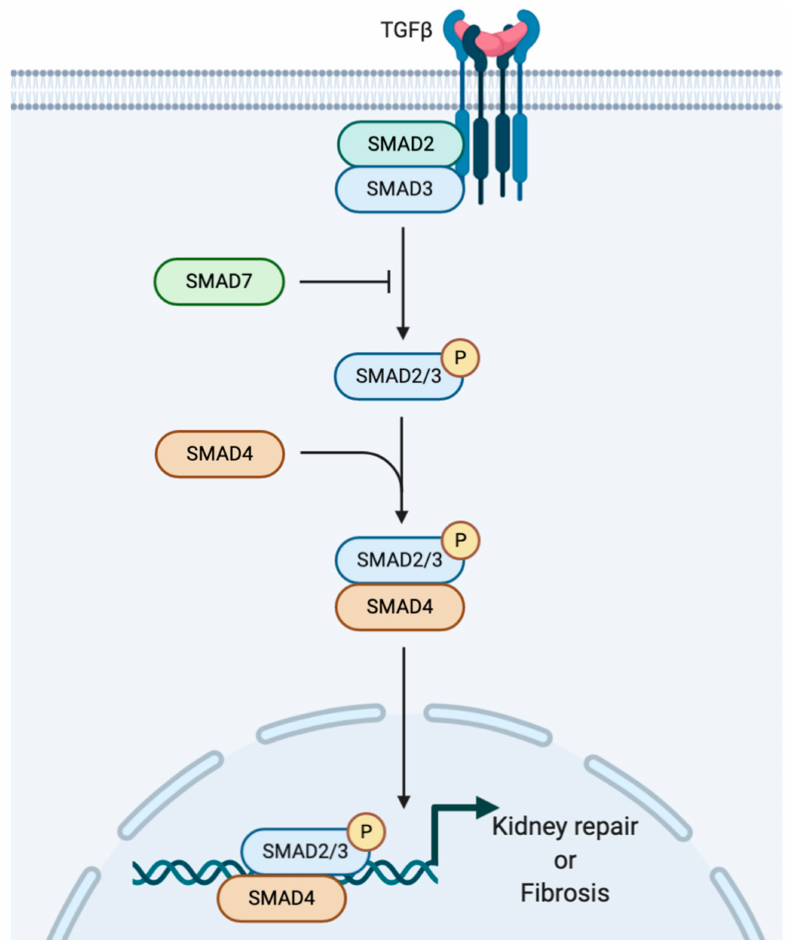
Figure 4. The role of TGF β in renal fibrosis. TGF β engages the ALK receptors to activate SMAD2-4 transcriptional programme. Initially TGF β plays a protective role by enhancing ECM production, such as COL1A2 , leading to tissue repair. However, excessive TGF β signalling can lead to tissue scarring further complicating renal